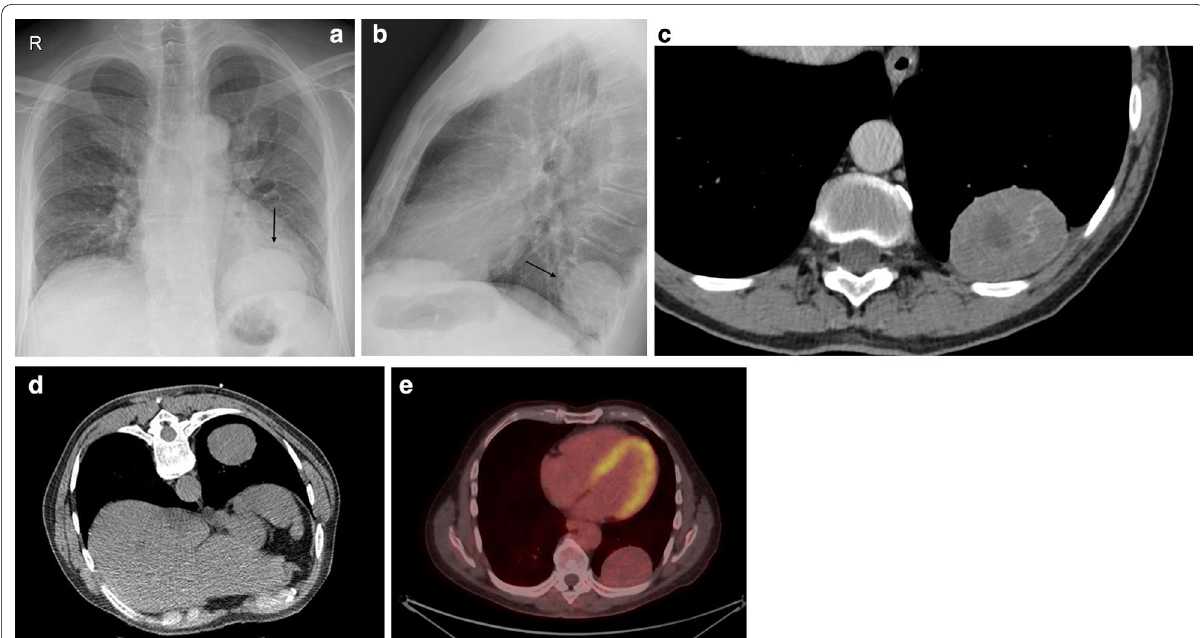
Fig. 3 Diagnosis: solitary fibrous tumor. Technique: standard chest radiography, contrast-enhanced chest CT and 18FDG-PET CT. Description: A 64-year-old man was referred for a chest radiograph as part of the investigations for gastro-intestinal complaints. Postero-anterior and lateral radiographs ( a , b ) show as incidental finding, a well-delineated mass (arrow) located posteriorly in the left lower lobe. Axial contrast-enhanced CT ( c ) in the mediastinal window setting shows a well-delineated pleural based heterogeneous mass with intralesional hypodense foci and areas of more prominent contrast enhancement. There is a change in location of the tumoral mass on the axial CT in the prone position ( d ), which was performed as part of a CT-guided biopsy. This change in location is an indirect sign suggestive of a pedunculated tumor. The lesion does not show high uptake on 18-F-FDG PET imaging ( e ). Imaging characteristics were suggestive of a solitary fibrous tumor. This was confirmed by histopathologic examination of the resected